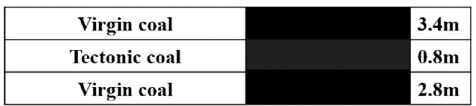
Figure 1. Schematic diagram of coal layers on the longwall face.